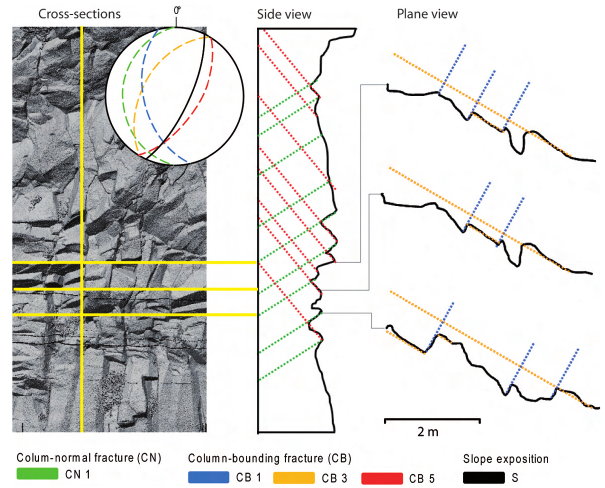
Fig. 8. To determine the size of possible planar sliding blocks at the outcrop shown, discontinuity sets have been plotted on cross- sections to measure their